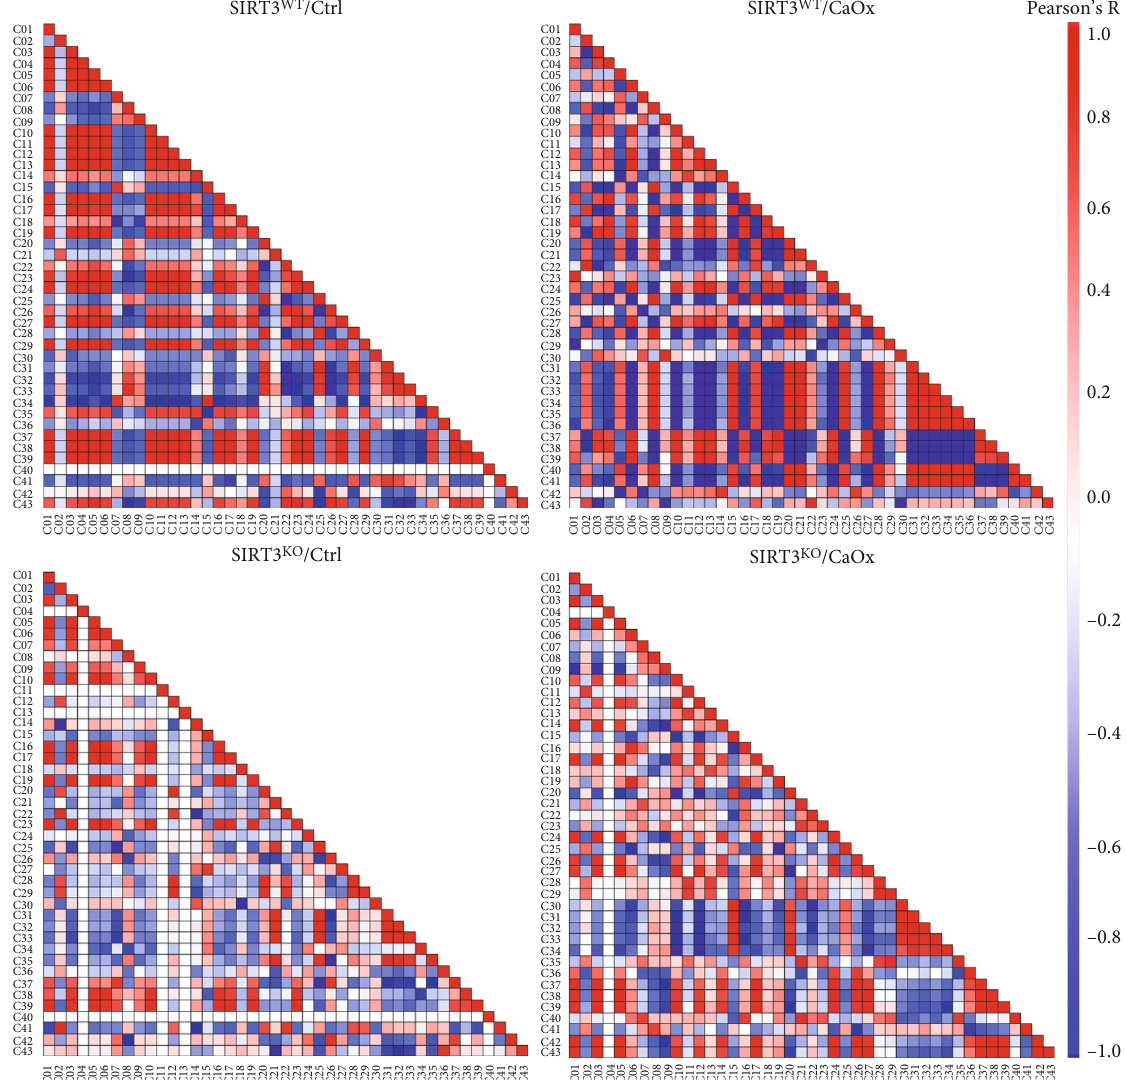
Figure 3: Heatmaps showing Pearson coe ffi cients of correlation for relationships between immune cell phenotypes in four di ff erent models with SIRT3 wild-type or knockout and CaOx inducement or